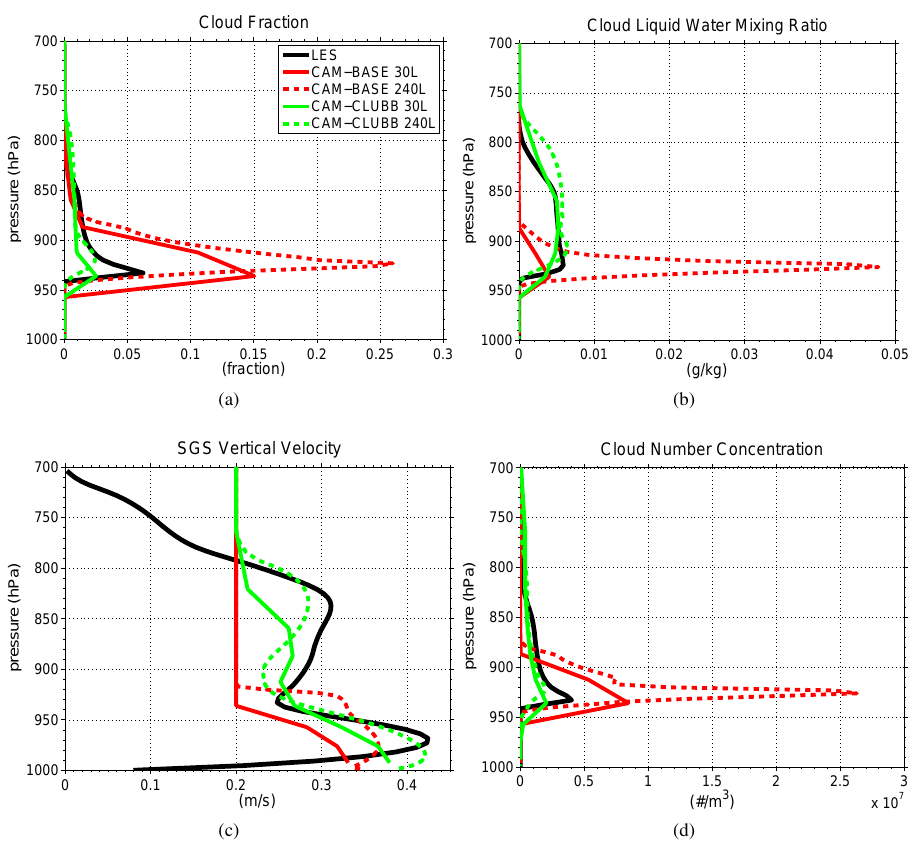
Fig. 2: Temporally averaged profiles of cloud fraction, cloud liquid water mixing ratio, SGS vertical velocity, and droplet number concentration from hours 4–6 of the simulation for the BOMEX case of non-precipitating trade-wind cumulus. LES is denoted by the solid black line, and SCAM simulations are denoted by the colored lines. Displayed here are simulations with 30 vertical levels (solid) and 240 vertical levels (dashed), both using a ∆ t =300s time step. Note that the minimum allowable SGS vertical velocity in CAM is 0.2ms − 1 .